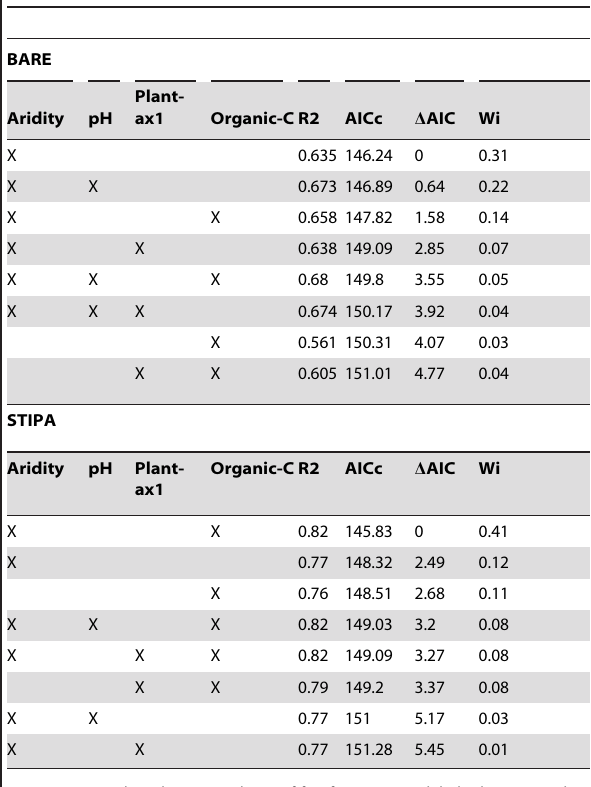
Table 1. Top eight best-fitting regression models, ranked according to their AICc value, are